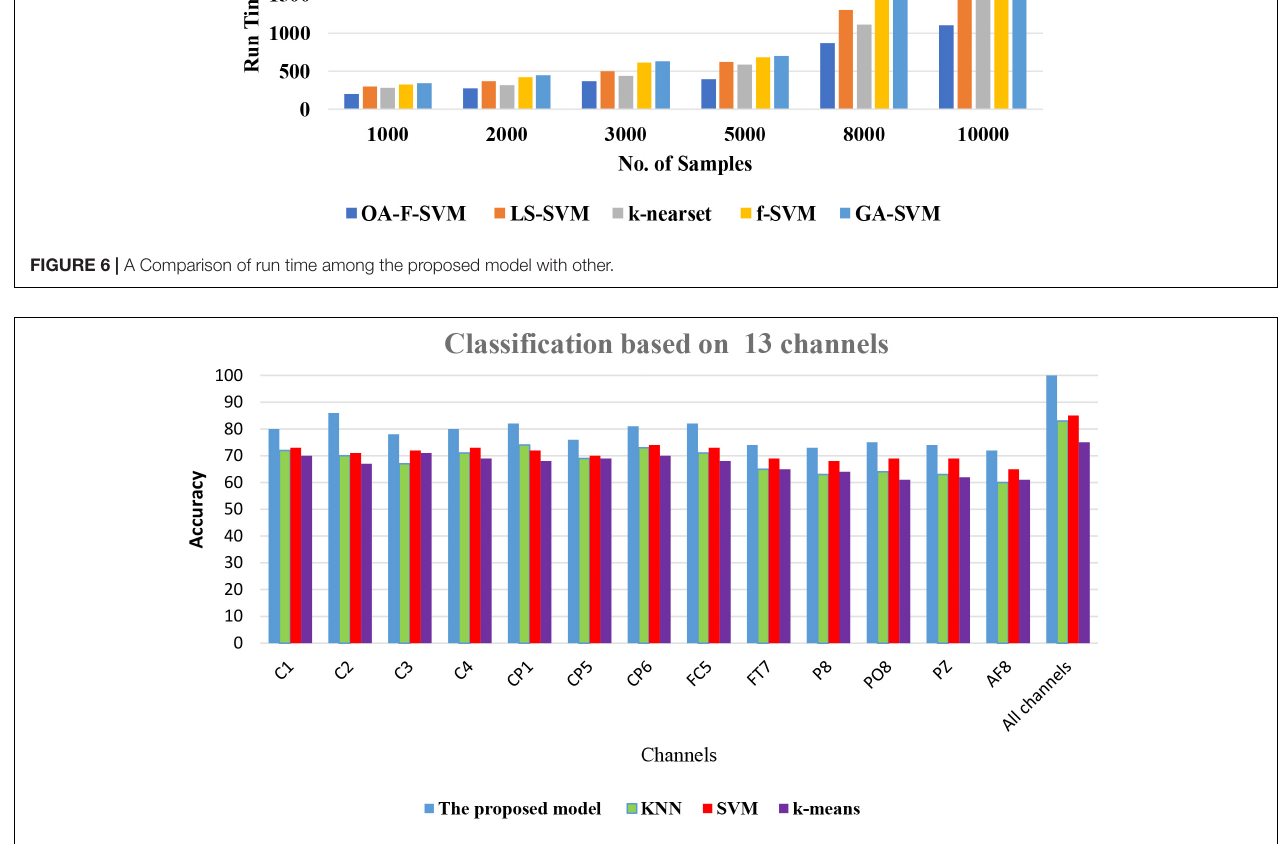
FIGURE 7 | A Comparison among the proposed model with SVM, k -means, and